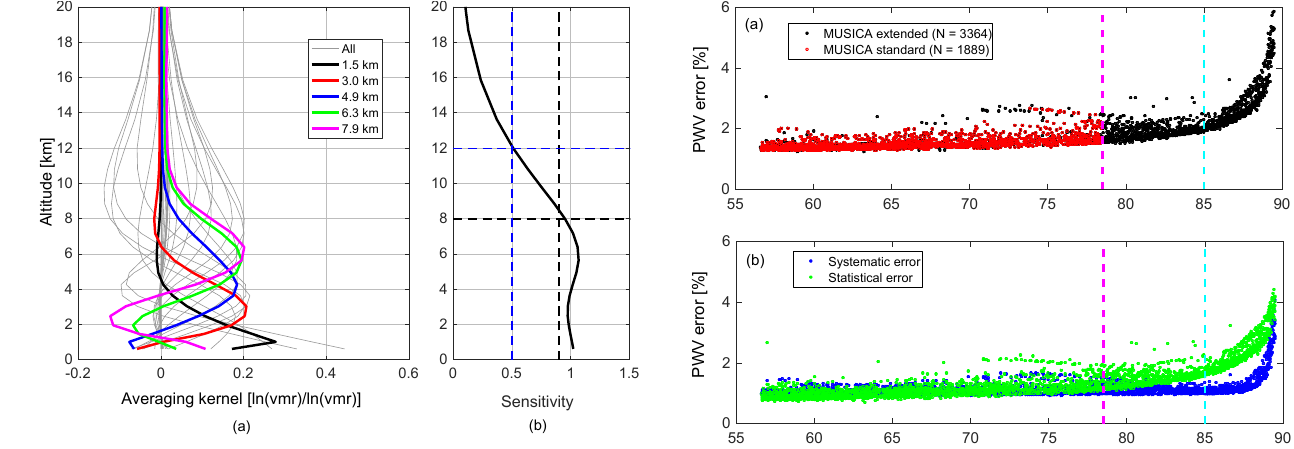
Figure 4. (a) Example of a typical MUSICA averaging kernel for a Eureka 125HR measurement, taken on 3 August 2006. Five al- titudes are highlighted in colour to illustrate the measurement’s ability to distinguish between different parts of the troposphere. (b) The retrieval’s sensitivity, i.e. the sum of the row kernels, with two thresholds for measurement information noted by dashed lines. The highest altitude where sensitivity is above 0.9 (8.0km) and 0.5 (12.0km) is shown using blue and black dashed lines, respectively.